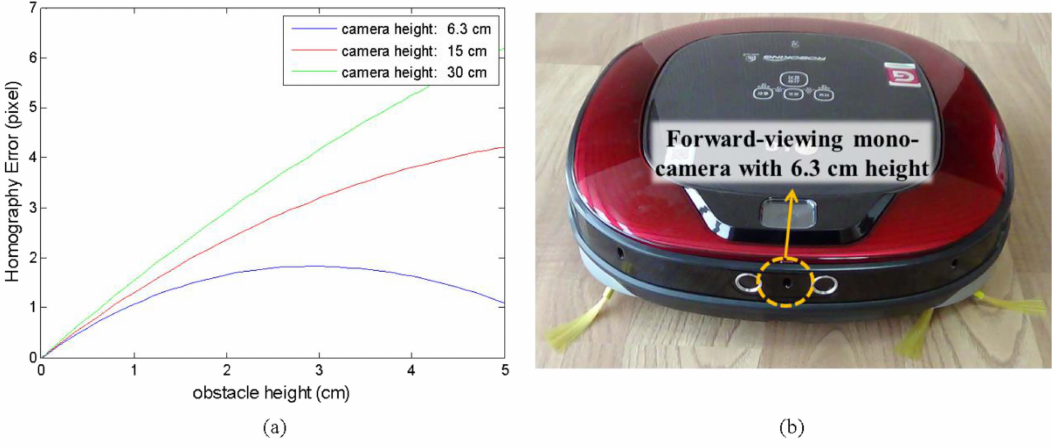
Figure 2. ( a ) Theoretical homography errors according to camera height when feature tracking is perfect. ( b ) Forward-viewing mono camera mounted at 6.3 cm above ground on a home service